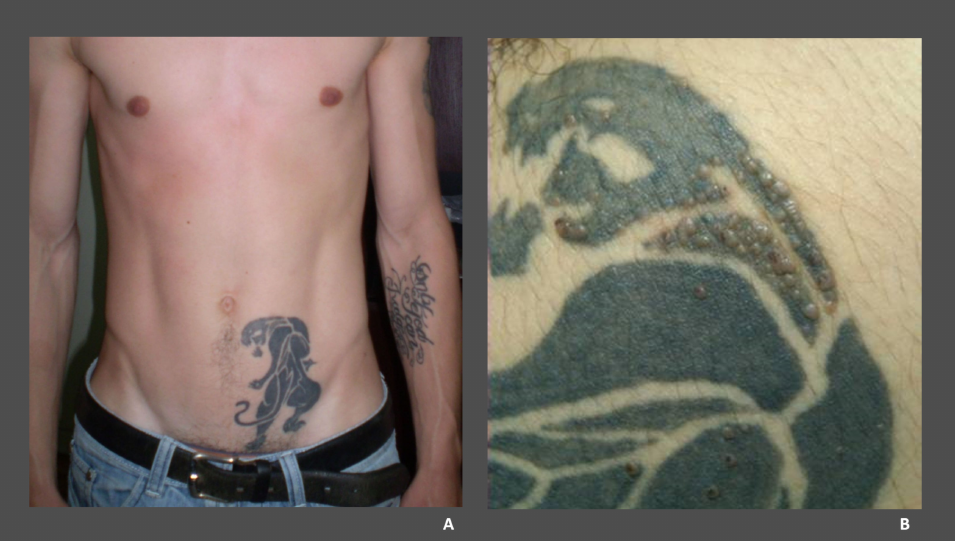
Figure 1. ( A ) A 32-year-old man with molluscum contagiosum on a black tattoo located on his left abdominal flank; ( B ) molluscum contagiosum papules strictly confined to the tattooed skin (images from our clinic, previously published in Tampa et al., 2012 [49]).